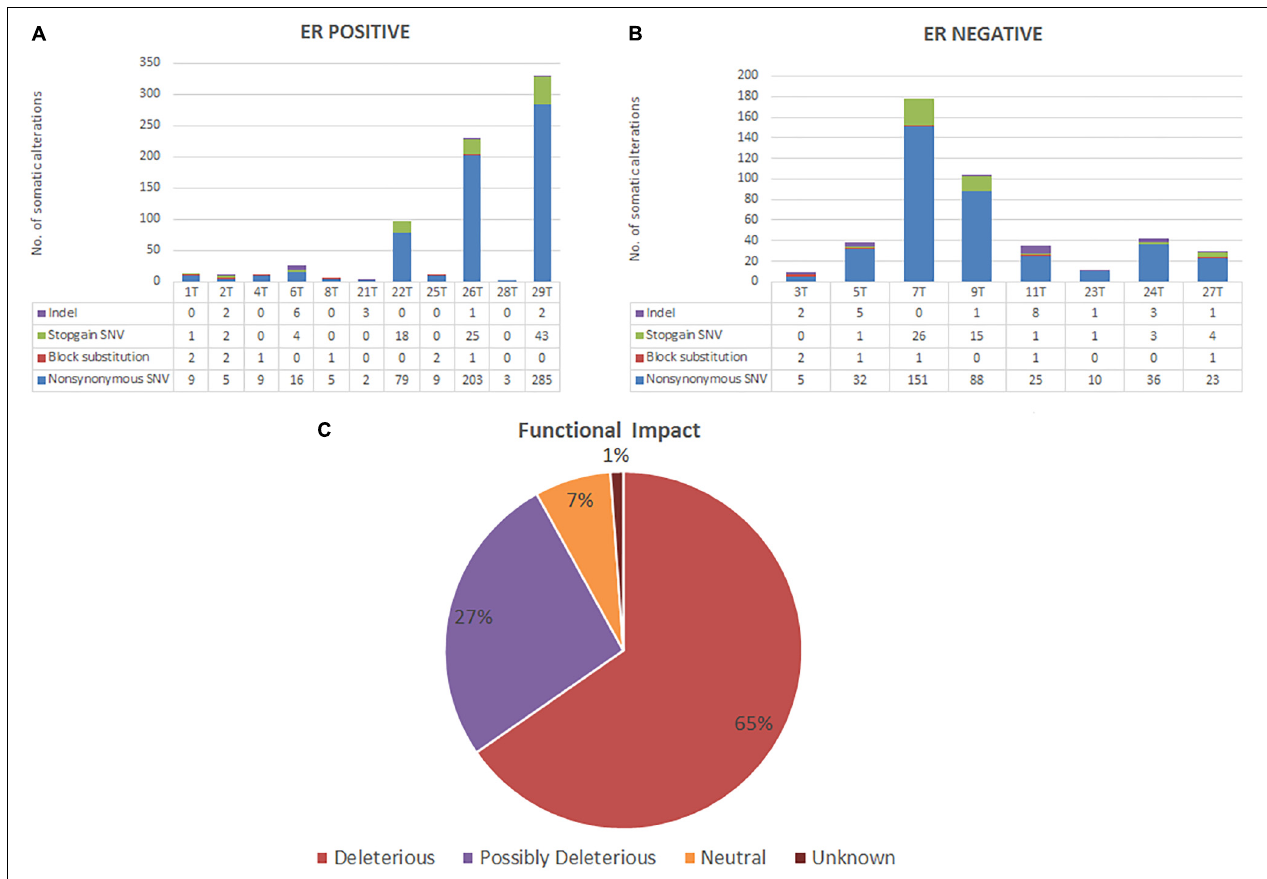
FIGURE 1 | (A,B) Bar charts showing the number of somatic alterations identified in each patients according to respective groups. Indel in these bar charts including frameshift and non-frameshift substitution. (C) Pie chart showing the frequency of functional impact of gene mutations based on protein prediction algorithms in